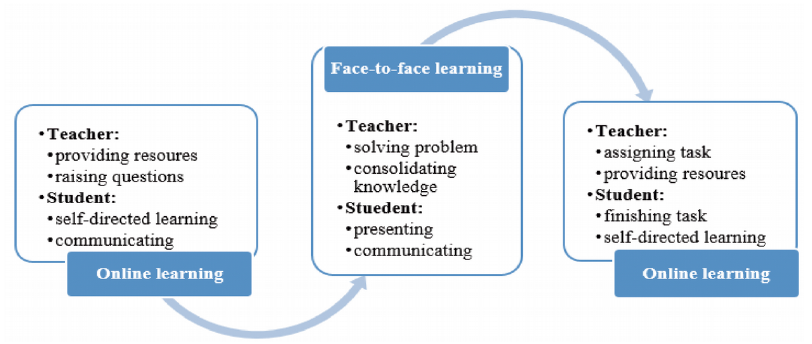
Figure 2. Structural Framework of Online Learning